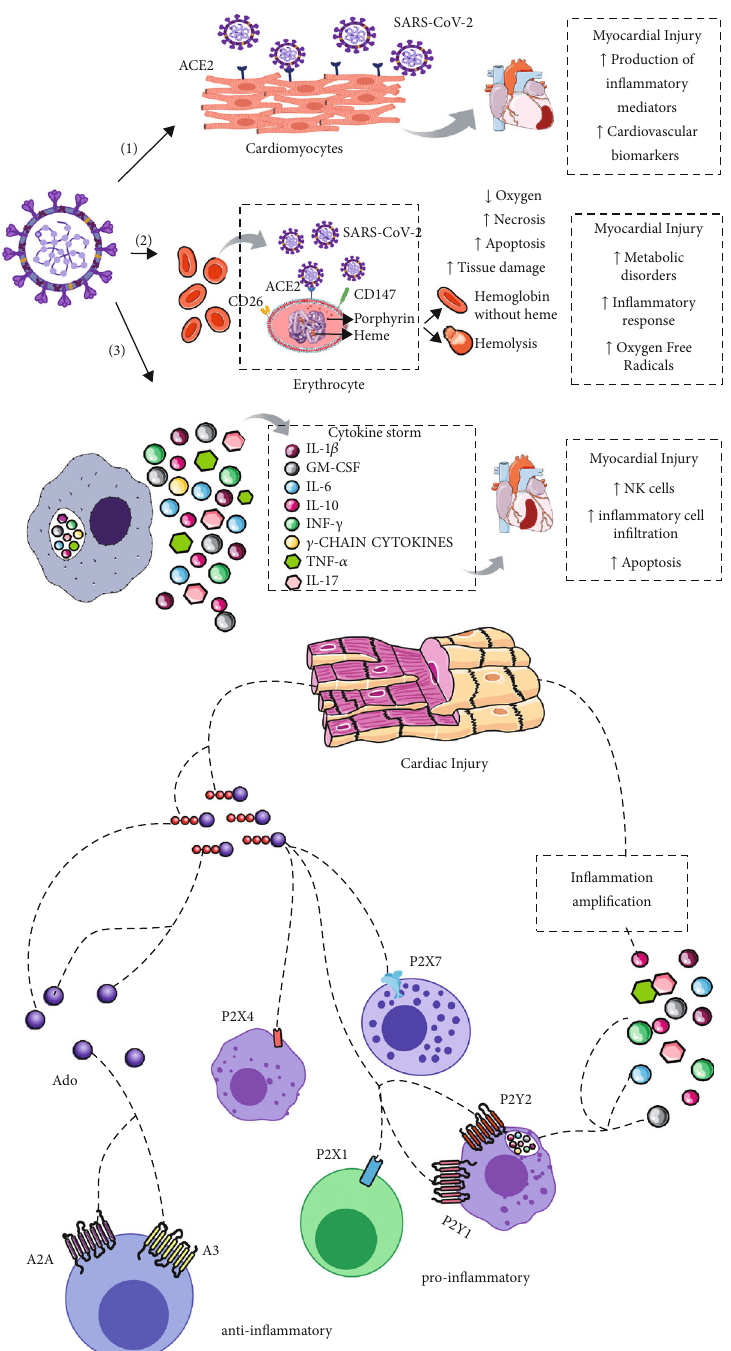
Figure 1: The cardiovascular system can be a ff ected by COVID-19 and can cause myocardial injury. We focused on three mechanisms: (1) by the angiotensin-converting enzyme II (ACE2), (2) by the respiratory dysfunction and hypoxemia due to COVID-19, and (3) by the cytokine storm syndrome, which results in damage to the myocardium. Myocardial injury releases extracellular nucleotide adenosine triphosphate (ATP), a proin fl ammatory danger signal via the upregulation of P2 purinoceptors located on immune cells (neutrophils, eosinophils, monocytes, macrophages, mast cells, and lymphocytes). ATP released due to the action of SARS-CoV-2 is an important mediator of in fl ammation, promoting the proliferation of immune cells and T cell activation, possibly contributing to the exacerbation of immunological responses and myocardial